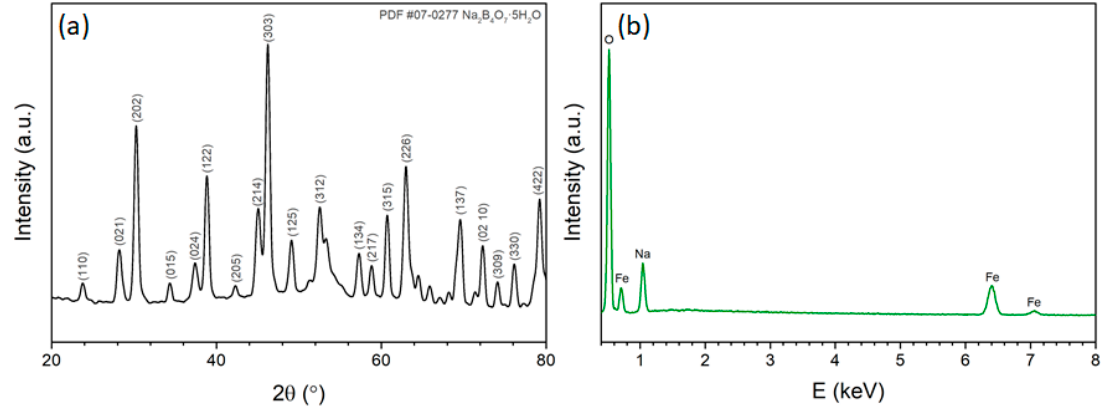
Figure 2. The XRD pattern ( a ) and the energy dispersive X-ray (EDX) analysis ( b ) of the powder obtained by reduction from Fe(NO 3 ) 3 with passivation in a current of 1% O 2 /N 2 in a Drexel bottle.